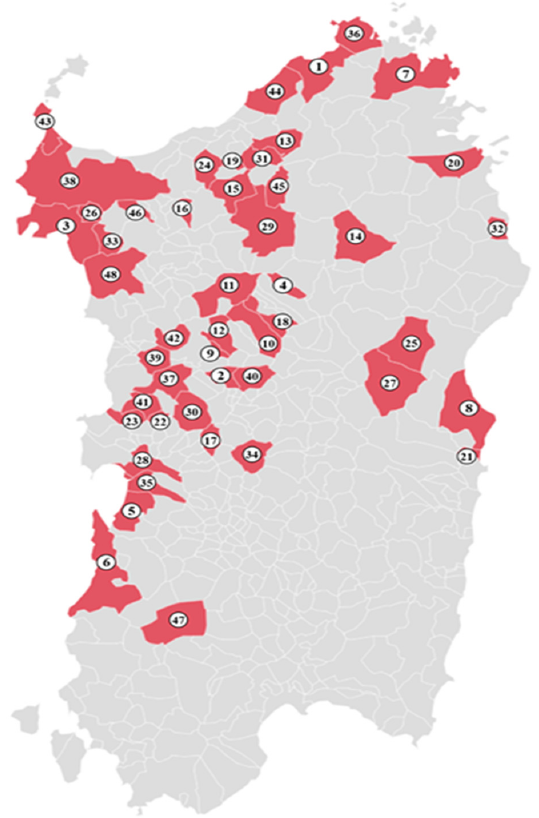
Figure 1. Map of Sardinia with sample collection sites for Babesia / Theileria molecular detection in mammals between 2020–2021 .